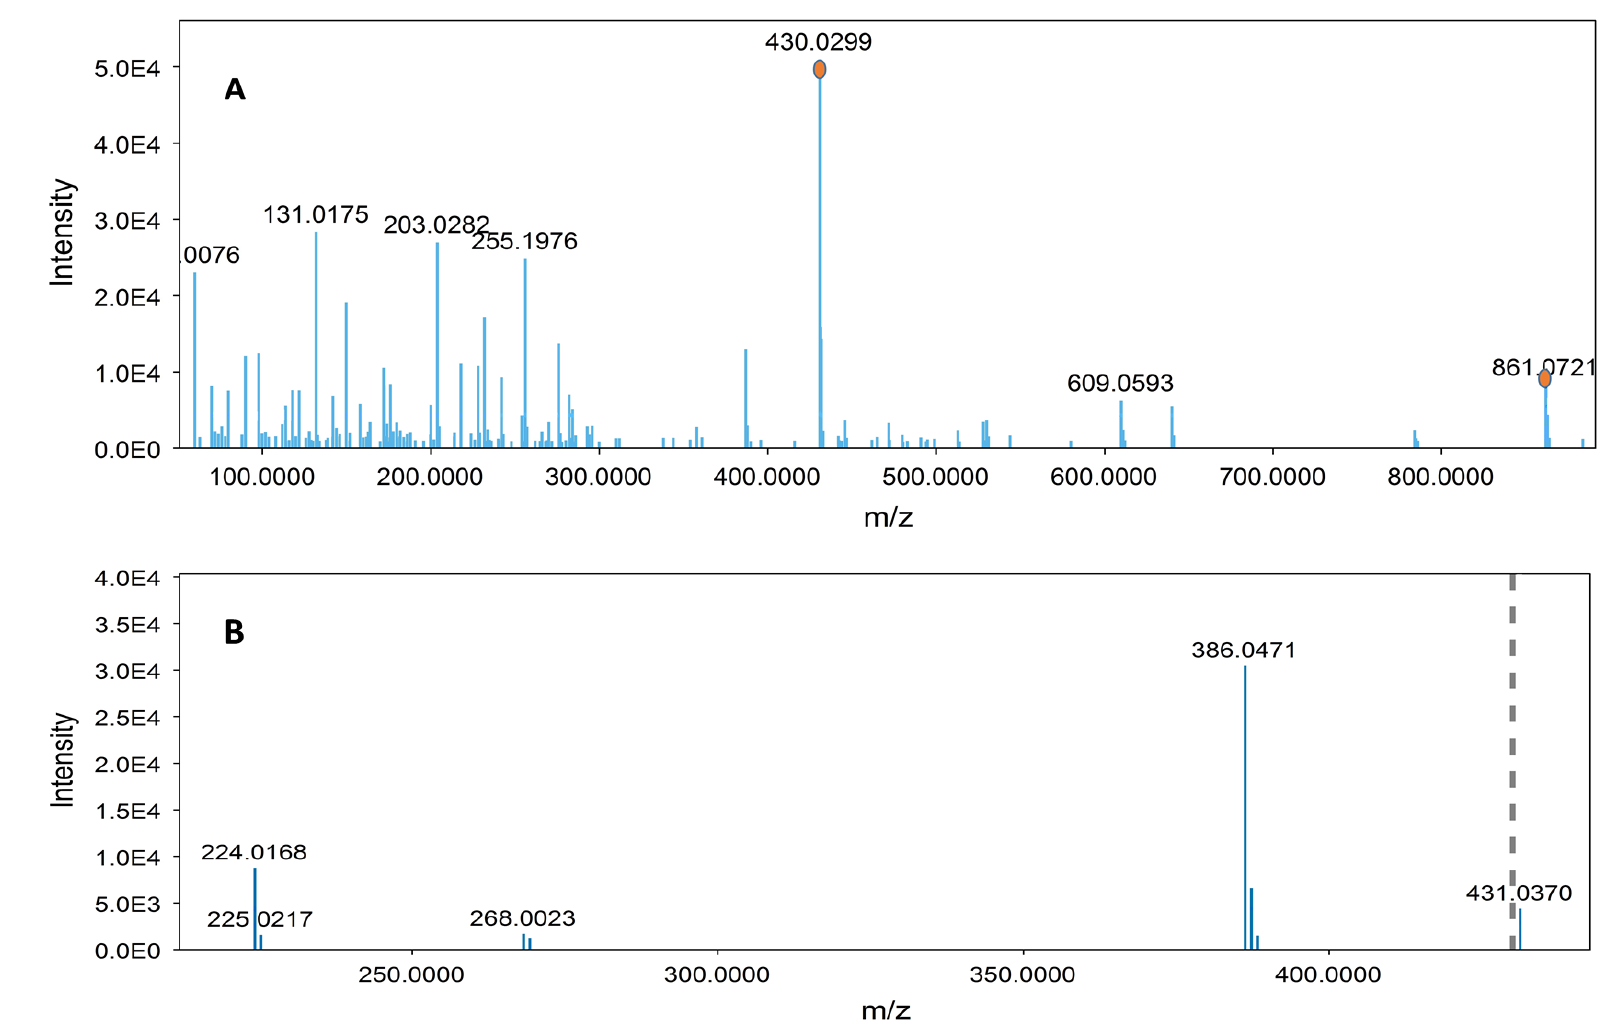
Figure 9. ESI − mass spectra of a sennoside: ( A ) parent [M-H] − ion of m / z = 861.0721; ( B ) MS2 spectrum of the ion m / z = 430.0370.